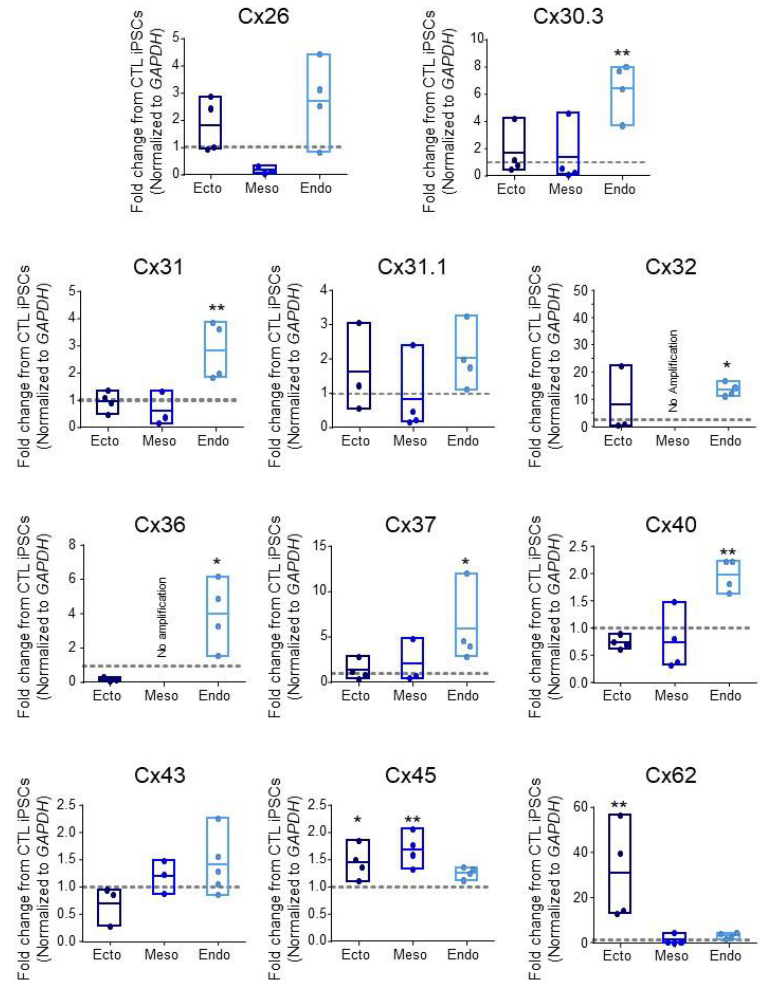
Figure 1. Connexin mRNA expression during human iPSC lineage specification. Quantitative RT-PCR (qPCR) expression of mRNA transcripts encoding 11 of the 21 human connexin isoforms in human control (CTL) iPSCs (grey dotted line) and after directed differentiation into ectoderm, endoderm, and mesoderm. Data represent the standard error of the mean of 3–5 independent experiments. * p < 0.05; ** p < 0.01 compared to undifferentiated iPSCs. Table 5. Expression patterns of 11 Cx isoforms in control human iPSCs and three germ